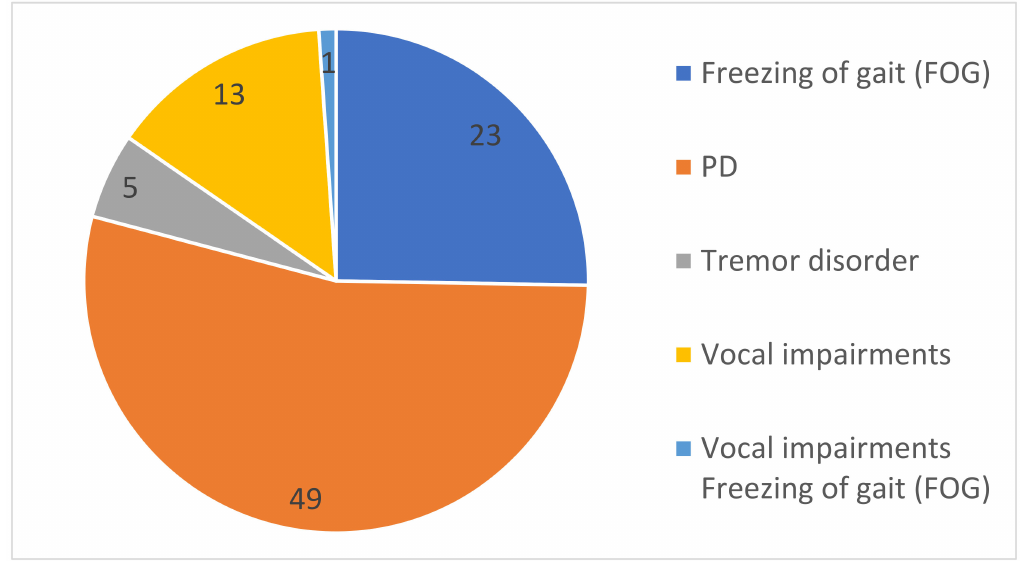
Figure 4. Different symptoms of Parkinson’s disease in the included